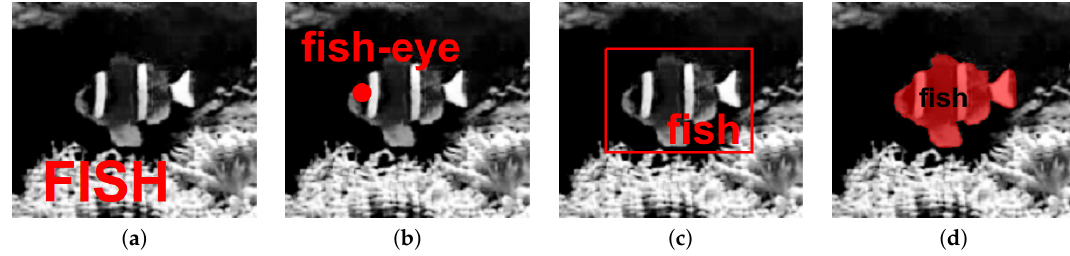
Figure 1. Types of 2D image annotation: ( a ) image tag; ( b ) landmark point; ( c ) bounding box; ( d ) individual pixels. Image from Fish4Knowledge dataset